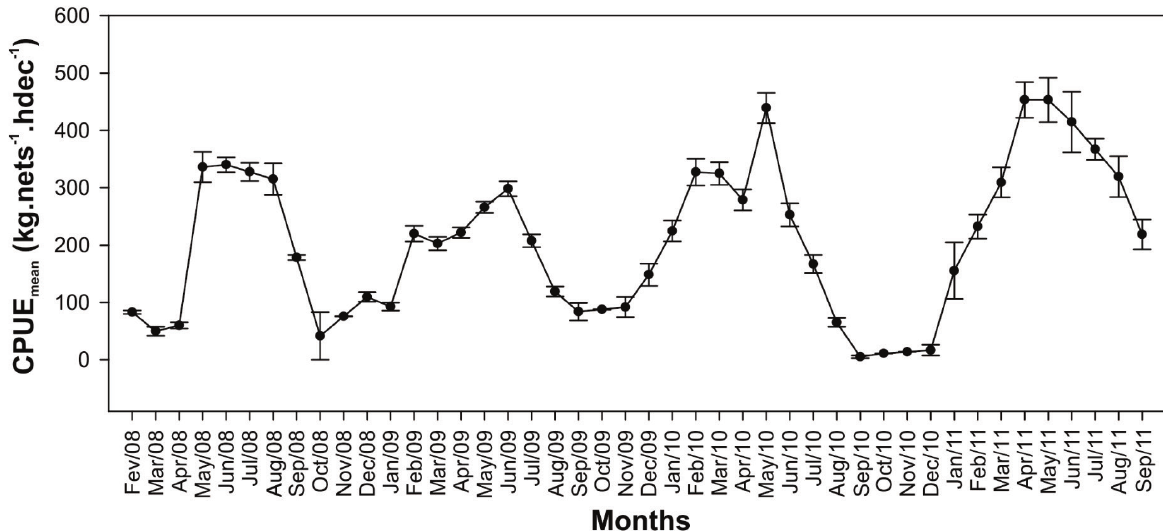
Figure 3. Lomb periodogram of the CPUE of Brachyplatystoma vaillantii showing a peak at a frequency of 0.0919 (period=~10.87 months). The dotted red lines show the significance tests of 0.01 (lower) and 0.05 (upper) through comparison with white